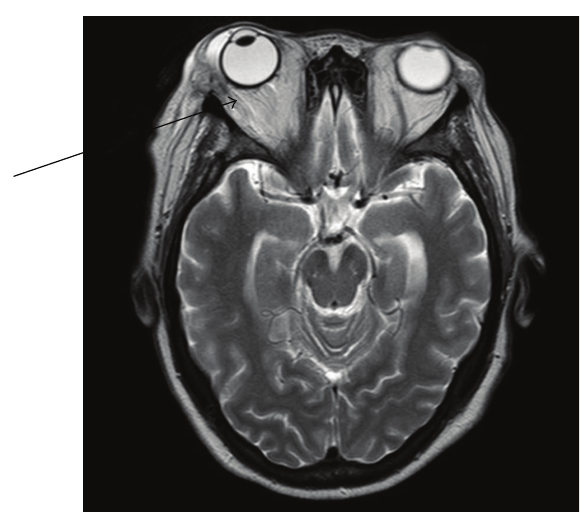
Figure 2: MRI of the orbit showing involvement of the greater wing of the sphenoid along with right orbital extension, involving the lateral rectus muscle and the lateral wall of the orbit as well as a right-sided preseptal soft tissue swelling and thickening.